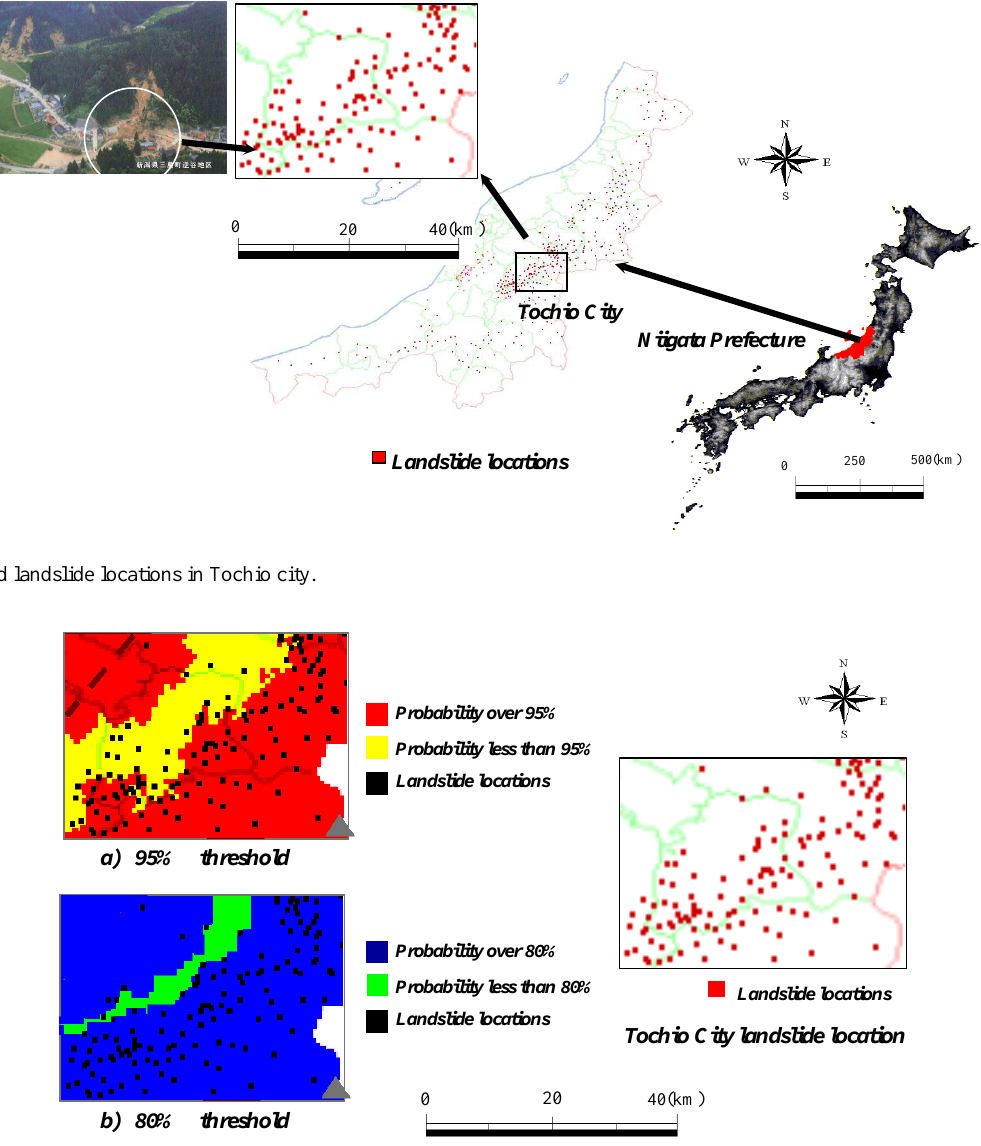
Fig. 8. Comparison of landslide hazard probability map and observed landslides in Tochio Figure 8. Comparison of landslide hazard probability map and observed landslides in